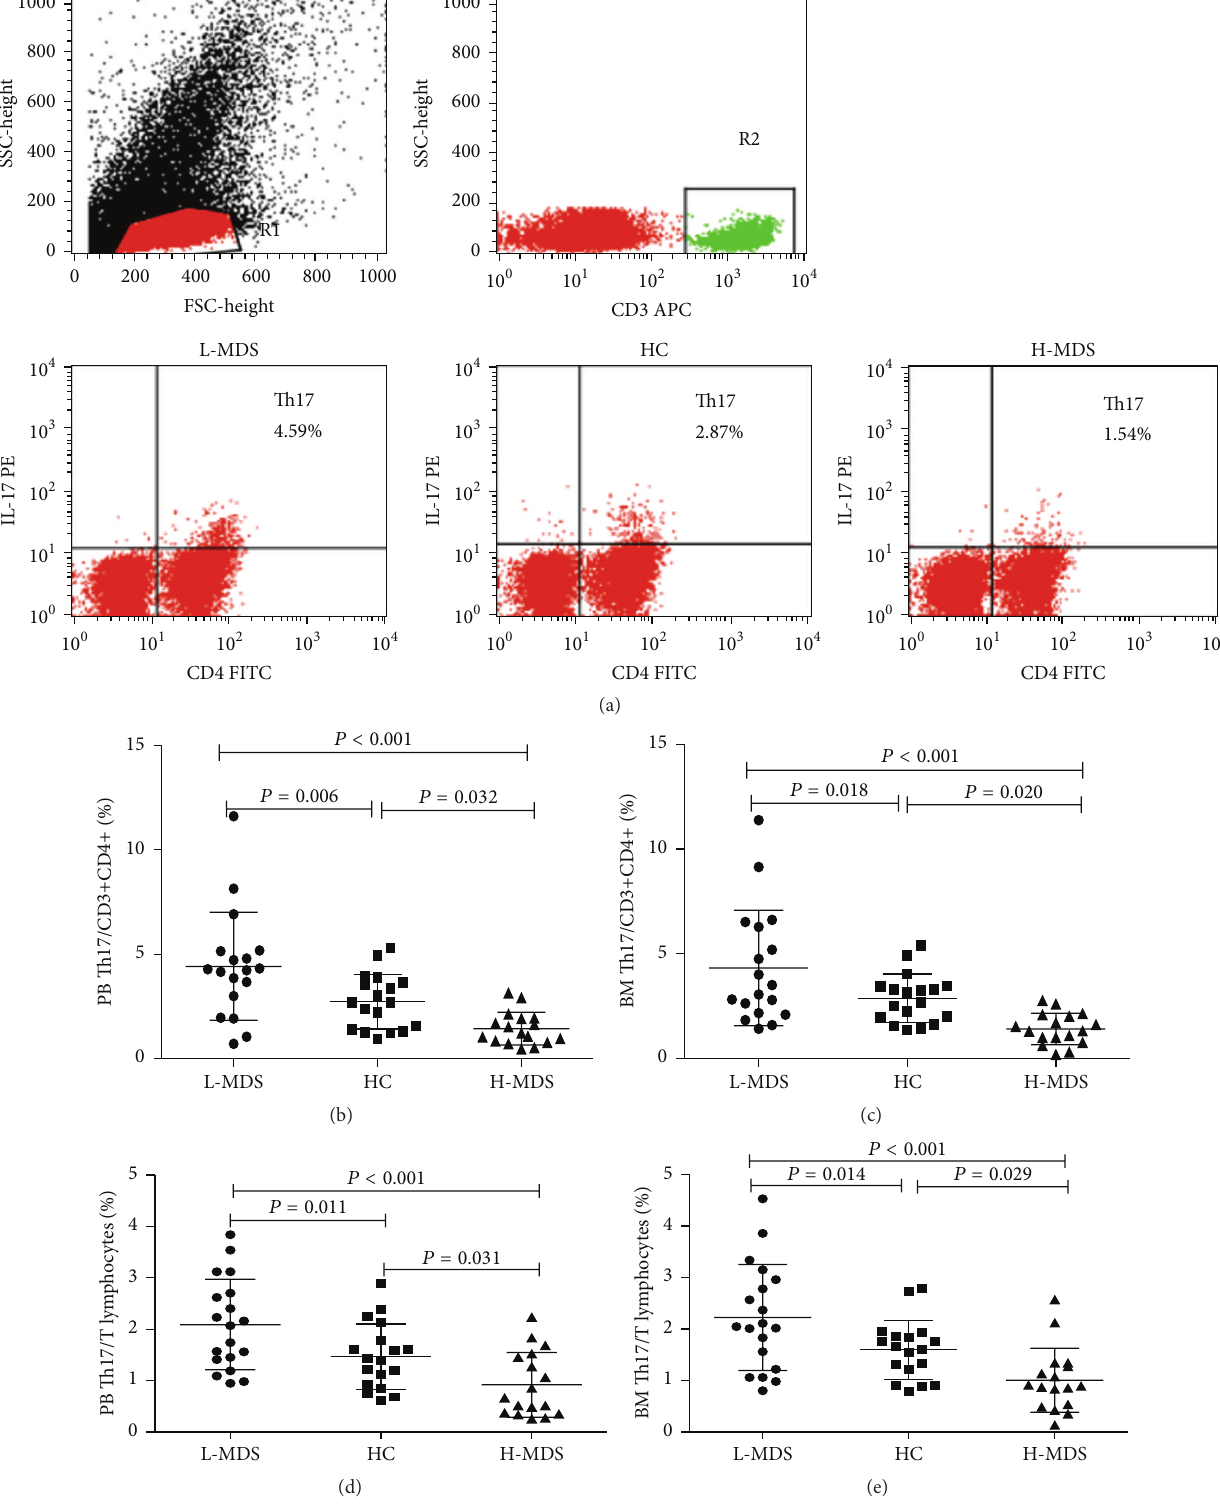
Figure 1: Th17 cells expand differentially in L-MDS and H-MDS patients. Lymphocytes were gated by flow cytometry. Representative FACS dot plots of Th17 (CD4+IL-17+) cells from L-MDS, HC, and H-MDS patients (a). Percentages of PB (b) and BM (c) Th17 cells in CD4+ T cells were shown. Percentages of Th17 cells in total T lymphocytes in PB and BM were also shown in (d) and (e),